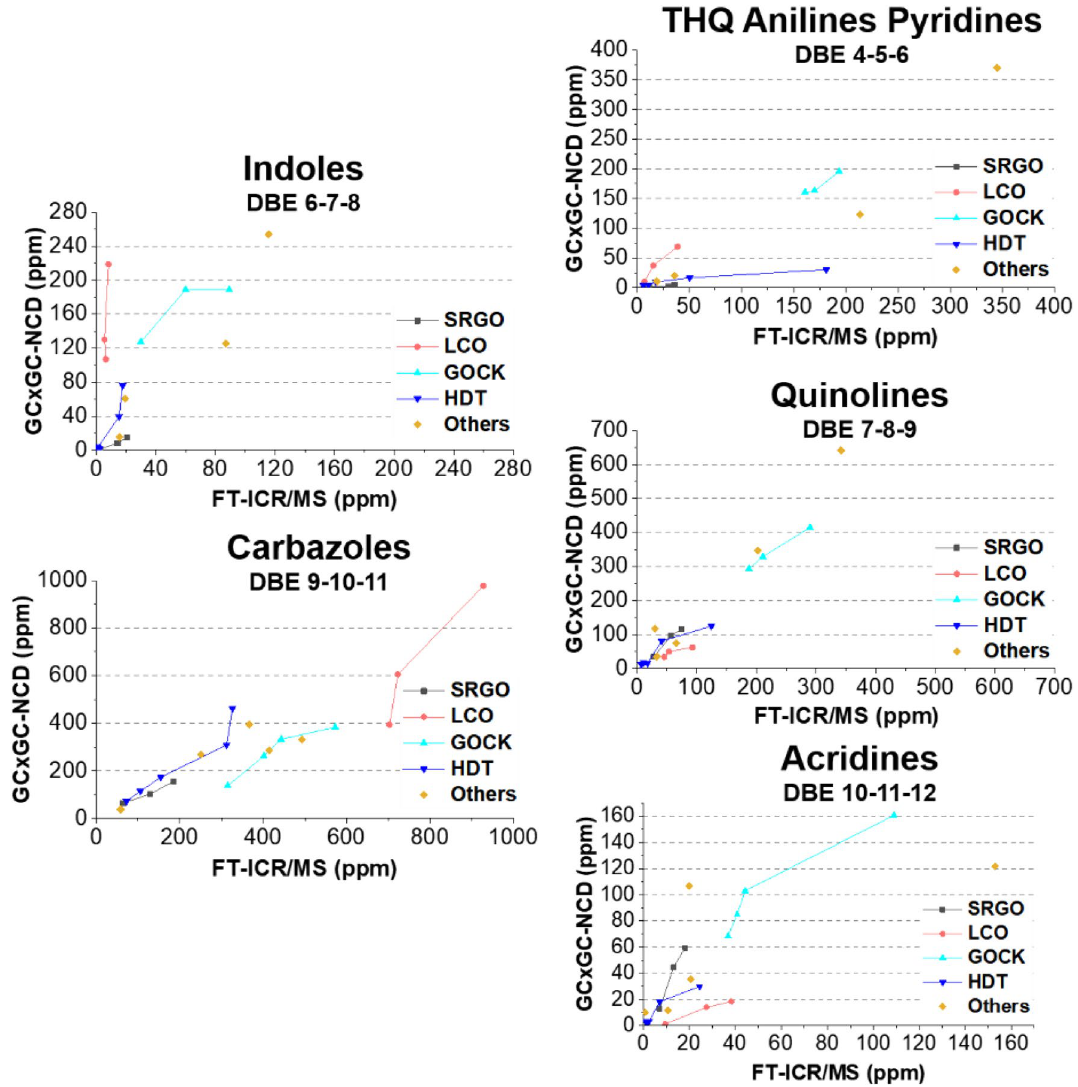
Figure 3. Comparison of the pseudo-concentrations obtained by GC × GC-NCD as a function of the pseudo- concentrations obtained by FT-ICR MS for the different nitrogen